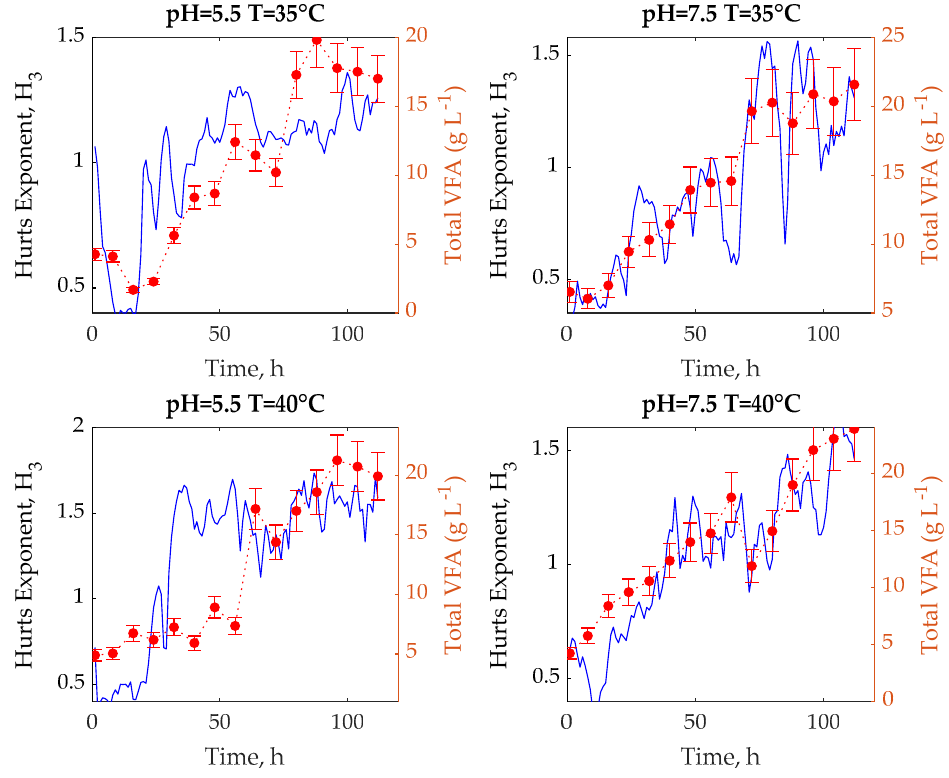
Figure 7. Correlations between Hd 3 and VFA produced measurements.